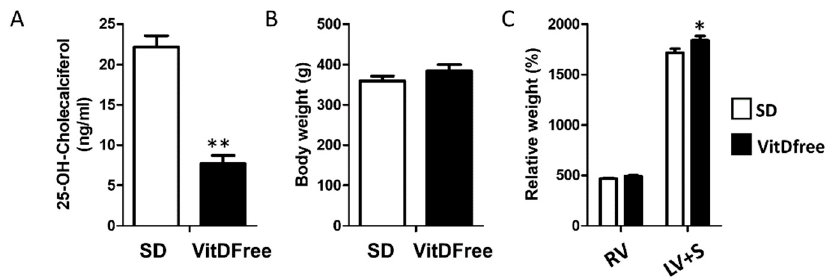
Figure 1. Vitamin D status, and body and heart weight. ( A ) Plasma 25OHVitD. ( B ) Body weight and ( C ) right ventricular (RV) and left ventricular + septum (LV + S) weights. Results are mean ± s.e.m. for the standard diet (SD, n = 10) and vitamin D-free diet group ( n = 10). Results were compared by student’s t-test * p < 0.05 and ** p < 0.01 vs. SD.